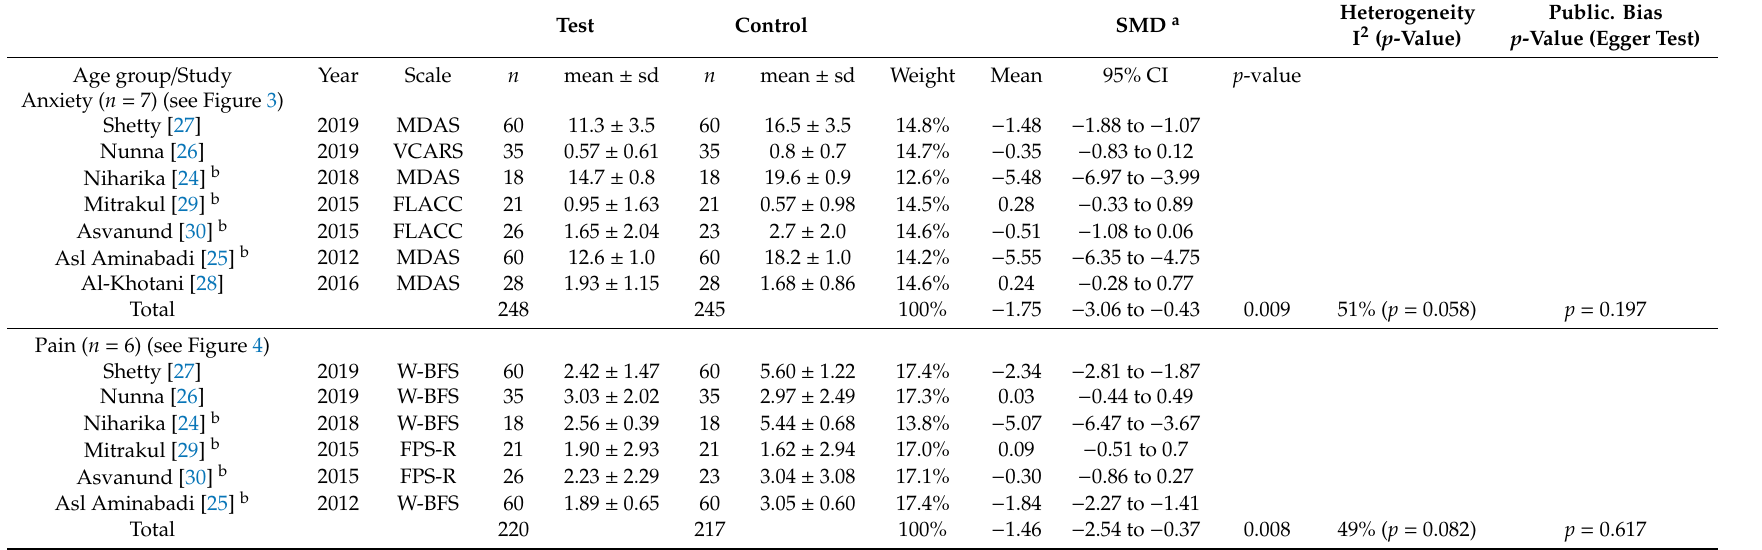
Table 2. Meta-analysis of anxiety and pain in children. Characteristics of individual studies and